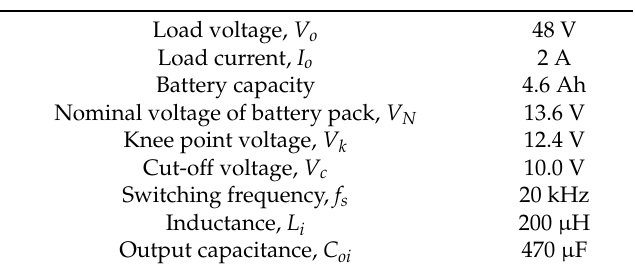
Table 1. Circuit parameters.